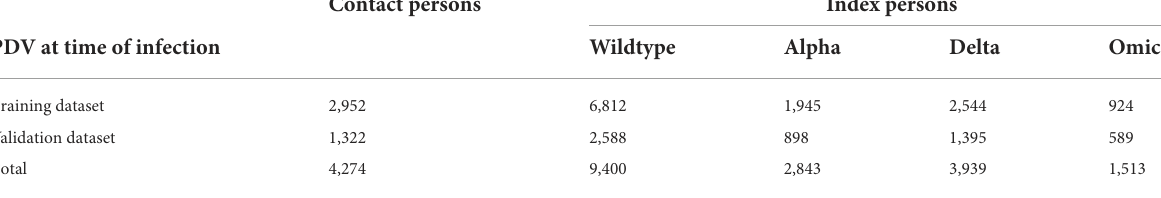
TABLE 1 Overview over the imbalanced distribution of prevailing dominant virus variant and contact persons in training, validation, and total